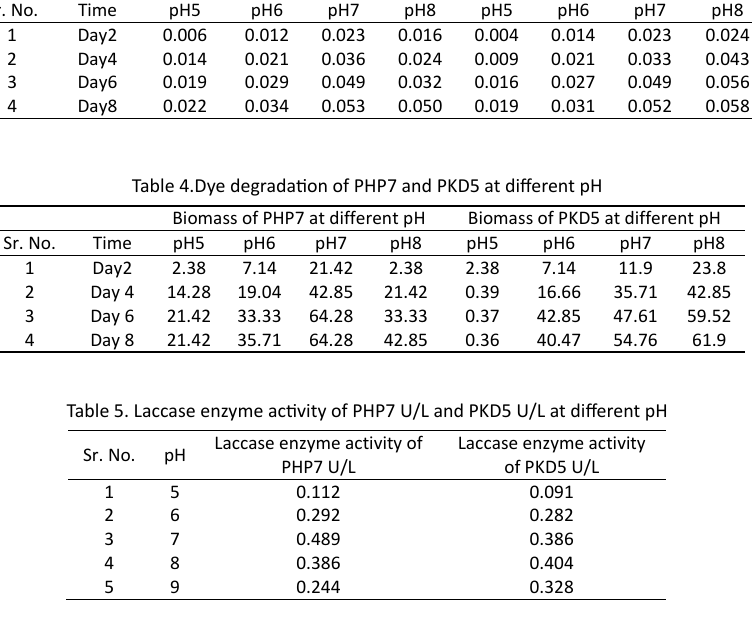
Table 3: Biomass of PHP7 and PKD5 at different pH Table 3. Biomass of PHP7 and PKD5 at different pH Biomass of PHP7 at different pH Biomass of PKD5 at different pH Sr. No.